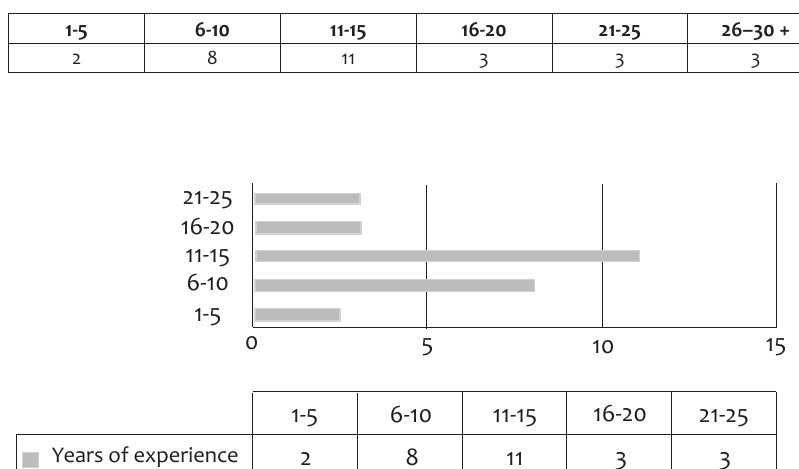
Table 2: Years of teaching experience